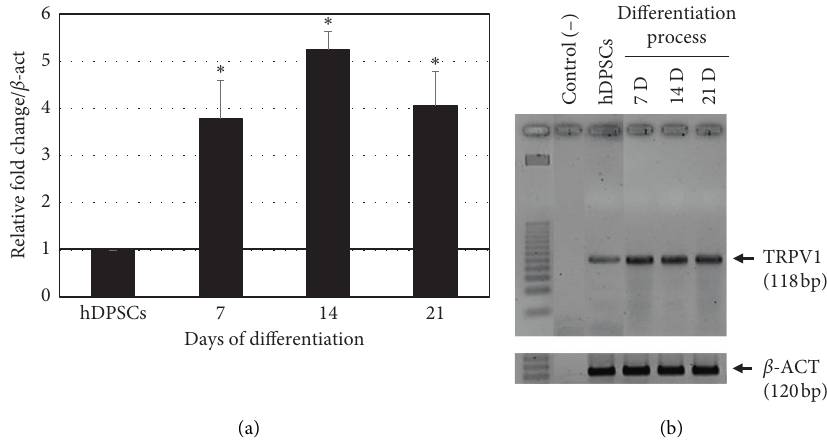
Figure 3: Relative quantification of TRPV1 at different differentiation times using RT-qPCR. (a) Relative quantification of TRPV1 transcripts using RT-qPCR in hOLCs cells at 7, 14, and 21 days of differentiation, compared to hDPSCs, which were used as baseline, and considered as 1. An overexpression of transcripts was observed for all the differentiation times. Results are presented as mean ± standard deviation (SD) of three independent experiments in triplicate ( n � 9). The asterisks show statistically significant differences between hDPSCs cells and the control ( p < 0 . 05). (b) Agarose gel electrophoresis (2%) of the TRPV1 products of RT-qPCR. An increase in the expression of the transcripts is observed at 7, 14, and 21 days of differentiation, compared to hDPSCs. β -actin ( β -ACT) was used as a housekeeping gene. GelDoc Go System reader was used (BioRad, Hercules, CA,